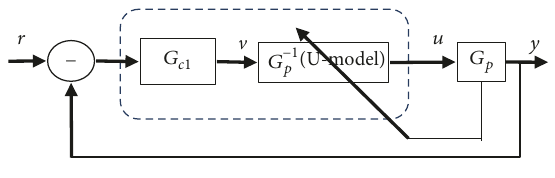
Figure 2: U-Model control